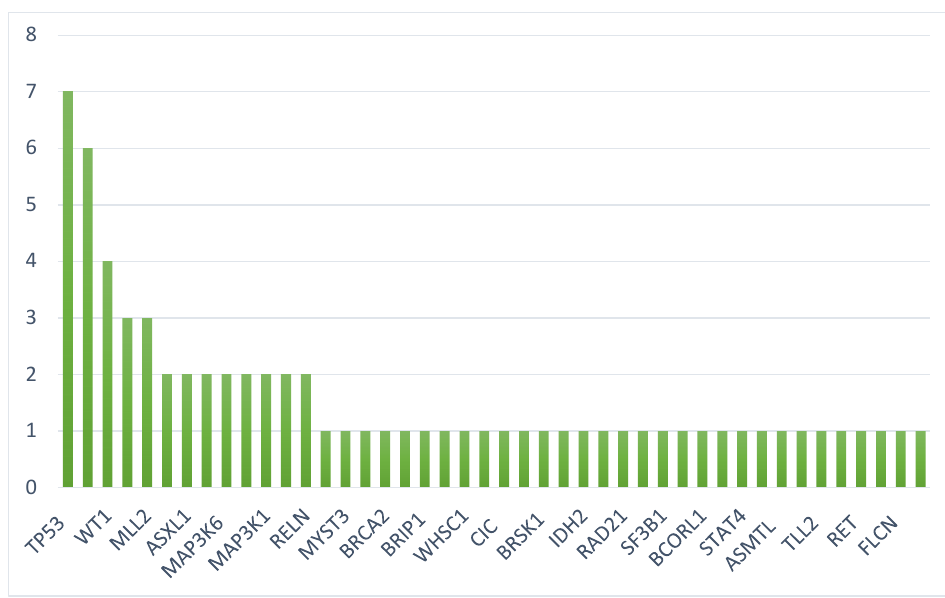
Figure 2. Mutation frequency in mixed-phenotype acute leukemia (MPAL).